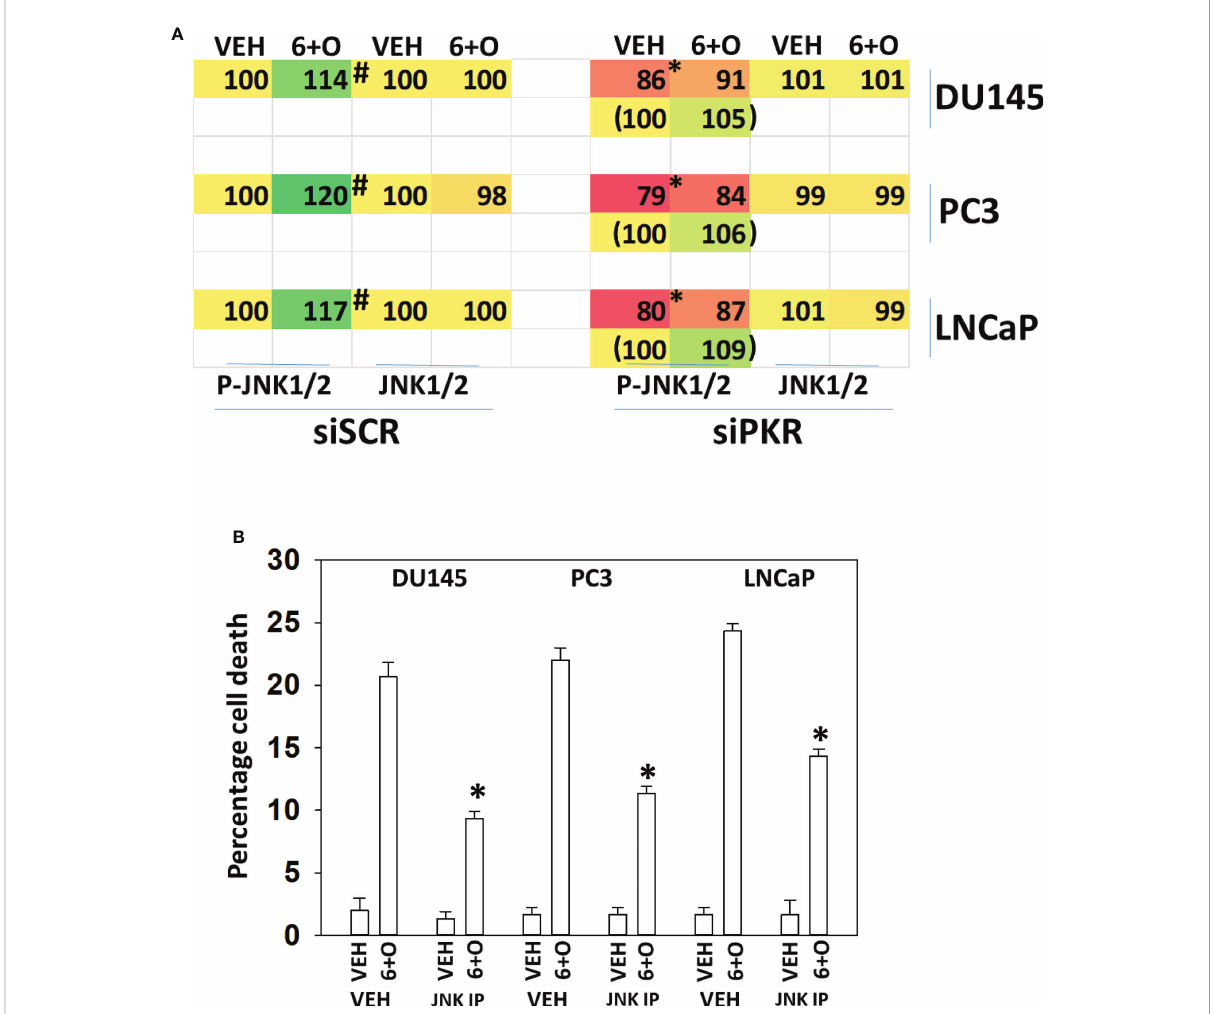
FIGURE 6 Activation of toxic JNK1/2 signaling by GZ17-6.02 and olaparib requires PKR. (A) Prostate cancer cells were transfected with a scrambled siRNA molecule or with an siRNA to knock down PKR expression. Twenty-four h later, cells were treated with vehicle control or with [GZ17-6.02 (2 m M) + olaparib (50 nM)] for 6h. Cells were fi xed in place and the phosphorylation and total expression of JNK1/2 determined. (n = 3 +/-SD) #p < 0.05 greater than corresponding vehicle control; *less than corresponding value in siSCR cells. (B) Prostate cancer cells were treated with vehicle control or with [GZ17-6.02 (2 m M) + olaparib (50 nM)] for 24h in the presence of vehicle (DMSO) or the molecular cell-permeant JNK inhibitory peptide (10 m M). Cells were isolated and viability determined by trypan blue exclusion assay (n = 3 +/-SD) * p < 0.05 less than corresponding value in vehicle control treated